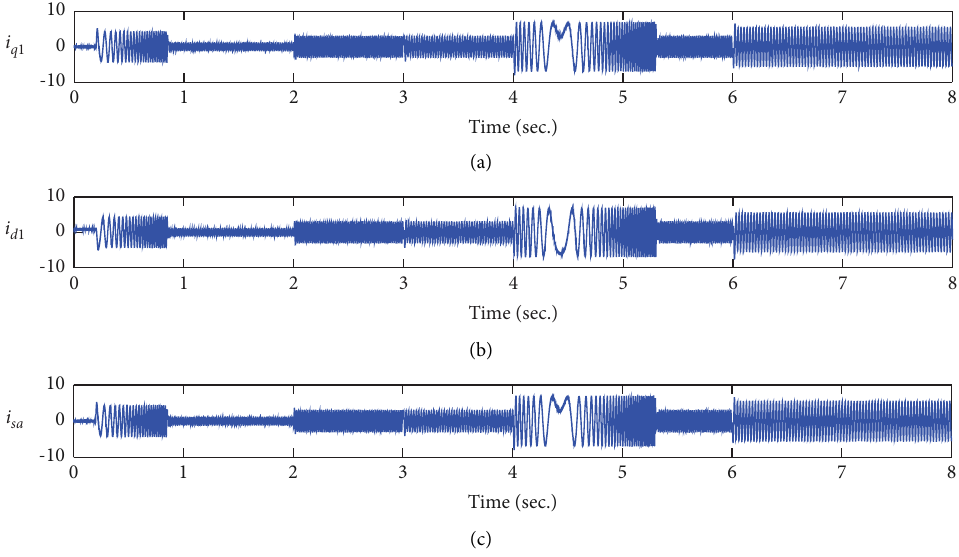
Figure 7: Resultant current fowing in winding set A .